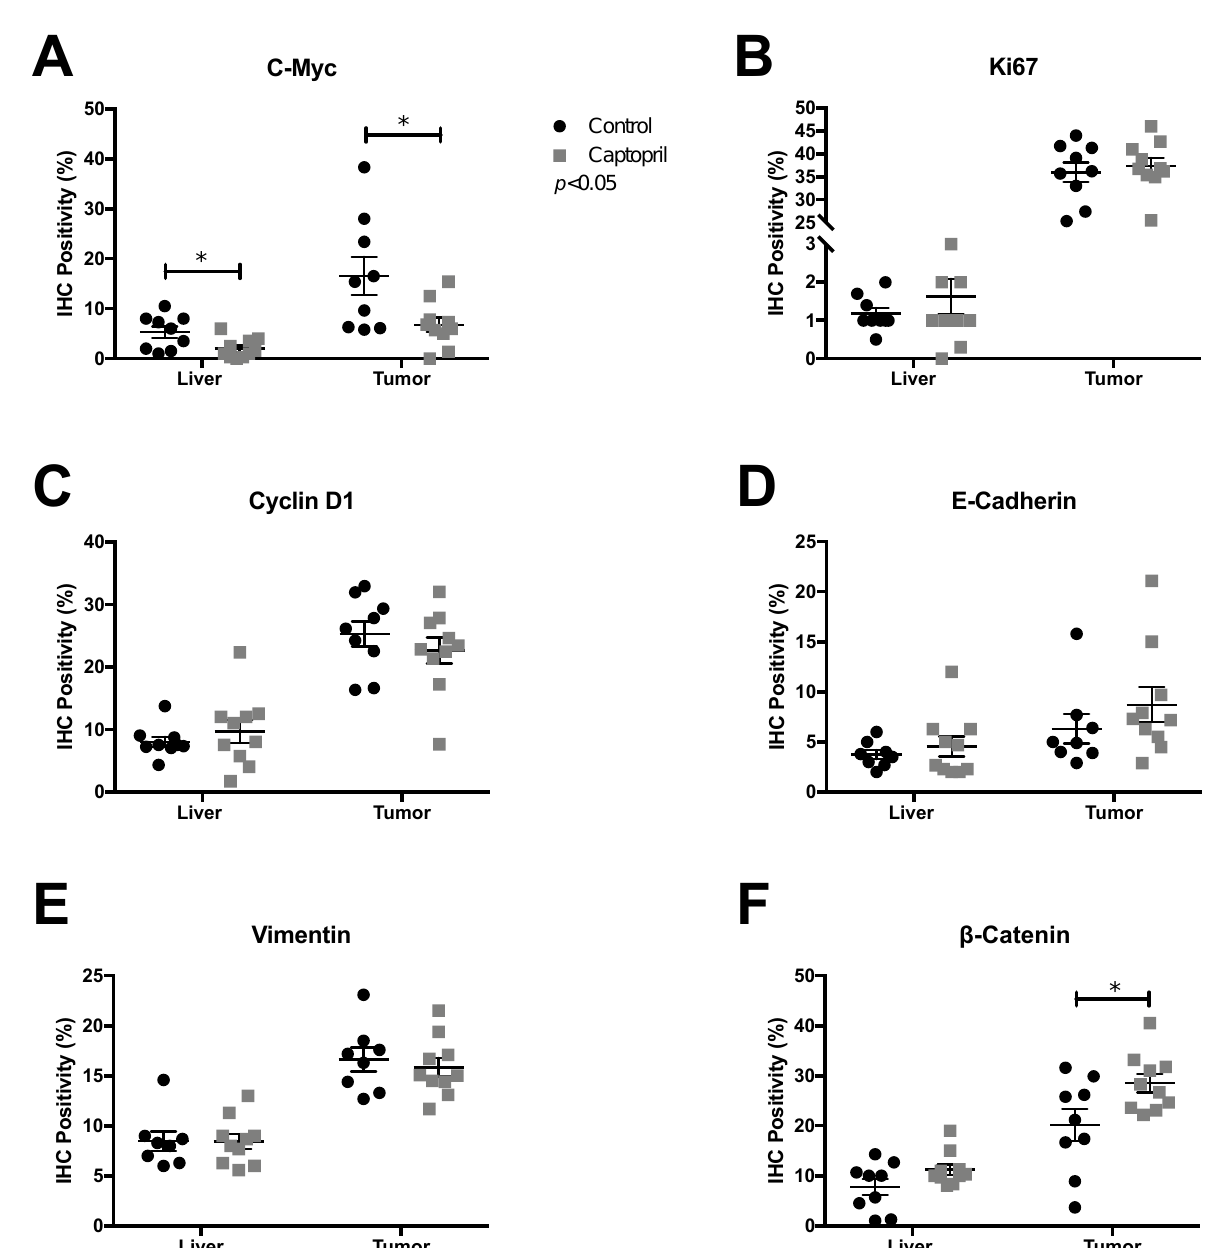
Figure 2. IHC on tissues from captopril treated and control mice. Fixed tissue sections (control, n = 9 and captopril, n = 10) were stained for the indicated proteins. Captopril treatment was associated with a significant reduction of ( A ) c-myc IHC detection in both the liver ( p = 0.0185) and tumor ( p = 0.0218) and a significant increase in ( F ) β -catenin IHC detection within tumor ( p = 0.0302). Captopril was not associated with any significant changes in ( B ) Ki67 IHC detection for either liver ( p = 0.3897) or tumor ( p = 0.6071), ( C ) Cyclin D1 IHC detection for either liver ( p = 0.4397) or tumor ( p = 0.3713), ( D ) E-Cadherin IHC detection for either liver ( p = 0.5041) or tumor ( p = 0.3148), ( E ) Vimentin IHC detection for either liver ( p = 0.9818) or tumor ( p = 0.6011) or β -catenin IHC detection in liver ( p = 0.0847). Unpaired, two tailed t -test. * p < 0.05.